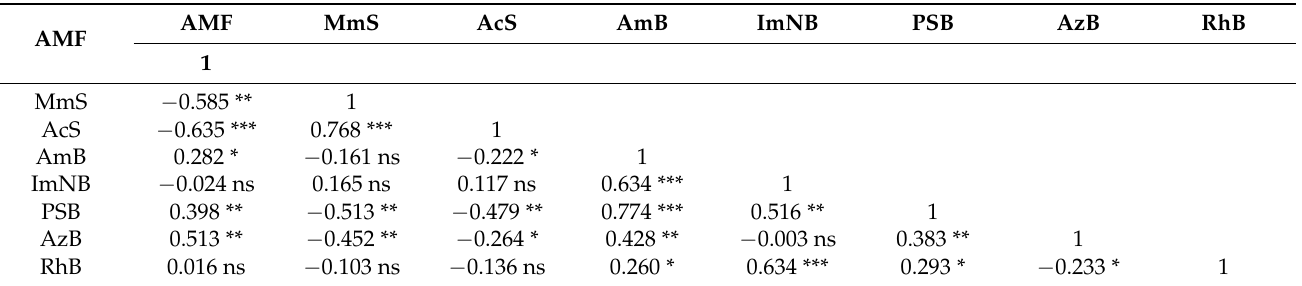
Table 1. Correlation (where r is Pearson’s coefficient) between the quantities of the trophic groups of microorganisms with the percentage of AM-colonization of garden pea roots in the microbial communities.